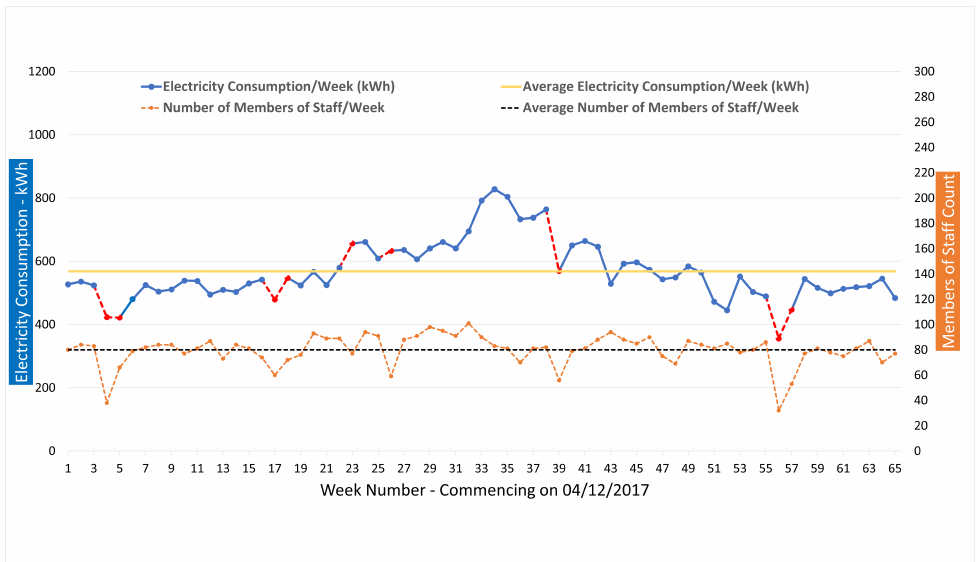
Figure 2. Relationship between electricity consumption and occupancy in the clinical engineering department.